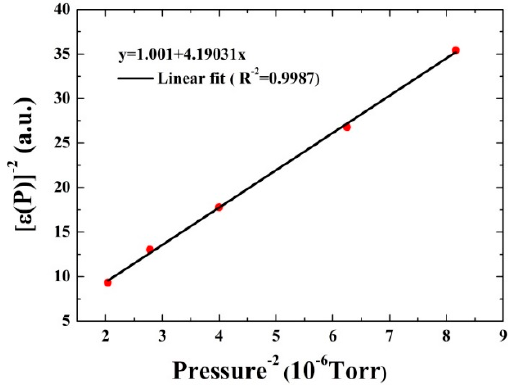
Figure 7. Experimental results (circles) and linear fit for determining the V-T relaxation rate of CO in dry N 2 .